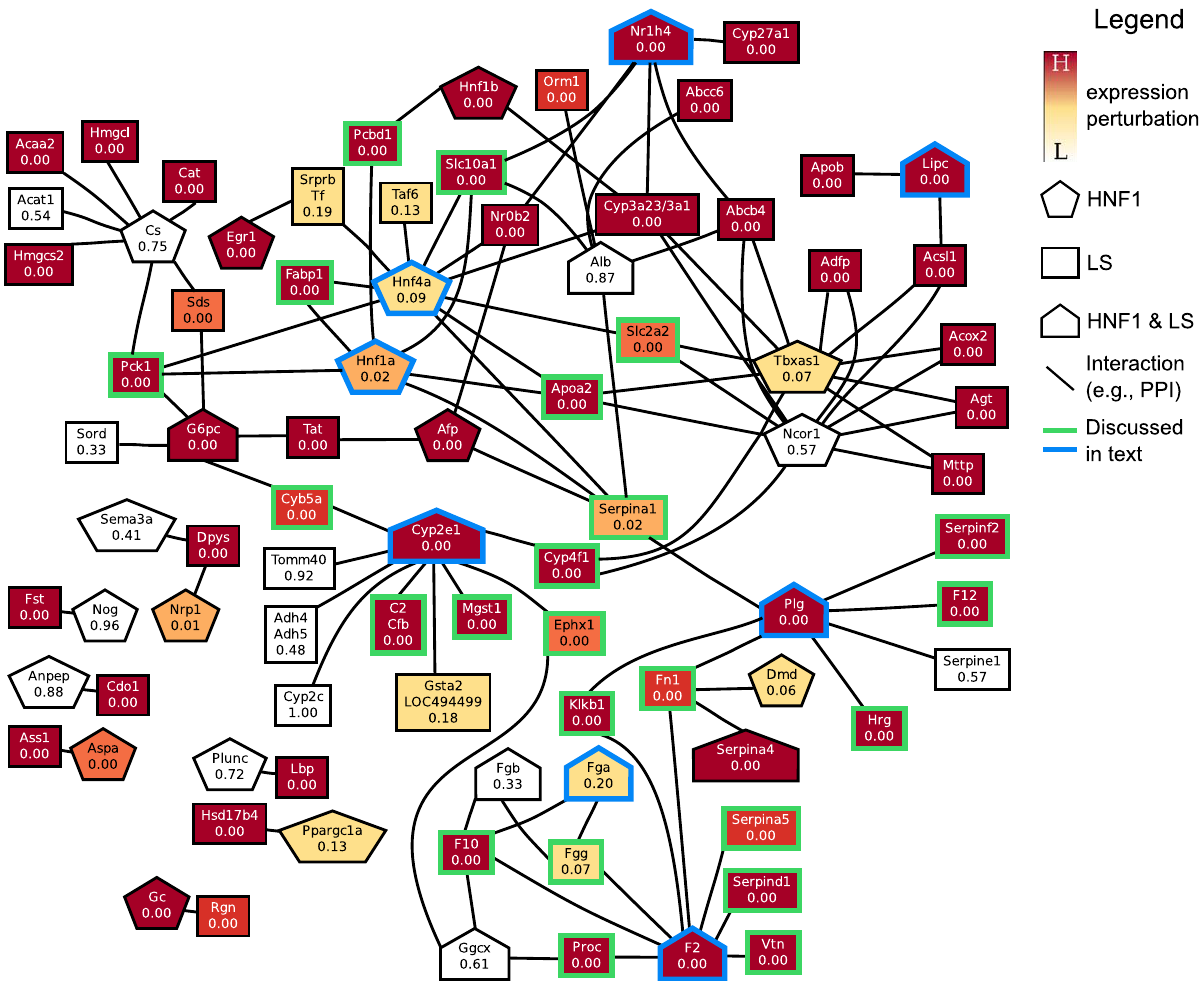
Figure 6. Network of functional interactions resulting in the link between V $ HNF1_Q6 and HSIAO_LIVER_SPECIFIC_GENES on day 8. In this and subsequent figures of such networks, each node represents a gene, and its color indicates the statistical significance of its perturbation (up- or down-regulation) in the contrast between CS and HM on the corresponding day. A node’s shape represents its membership within the two gene sets: a pentagon represents membership in the first gene set (i.e., V $ HNF1_Q6), a rectangle represents membership in the second gene set (i.e., HSIAO_LIVER_SPECIFIC_GENES), and the house shape represents membership in both gene sets. Nodes with blue (respectively, green) borders are those genes in the first (respectively, second) gene set that we mention or discuss in the text. An edge connecting two nodes represents a functional interaction as predicted by STRING. To increase clarity, we do not display interactions between genes within the same set. Abbreviations: HNF1: annotated with V $ HNF1_Q6, LS: annotated with